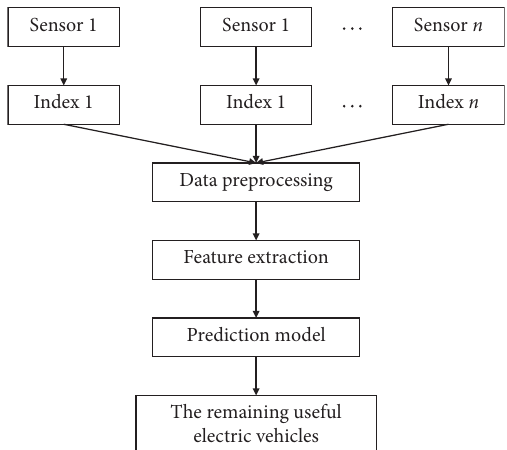
Figure 7: Flowchart of electric vehicle life prediction based on detection